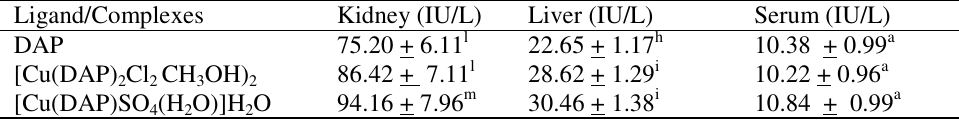
Table 5. Effects of administration of DAP and its complexes on alkaline phosphate activities of rat